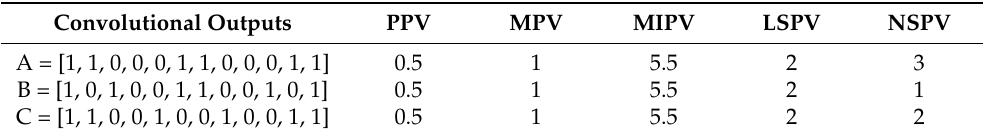
Table 3. The summary of pooling operators in improved MultiRocket uses a virtual example to illustrate that the four pooling operators in original MultiRocket cannot distinguish different sce- narios with different convolutional outputs. Each convolutional output contains 6 zeros and 6 ones, MPV = 1, PPV = 0.5, MIPV = 5.5, LSPV = 2. Convolutional